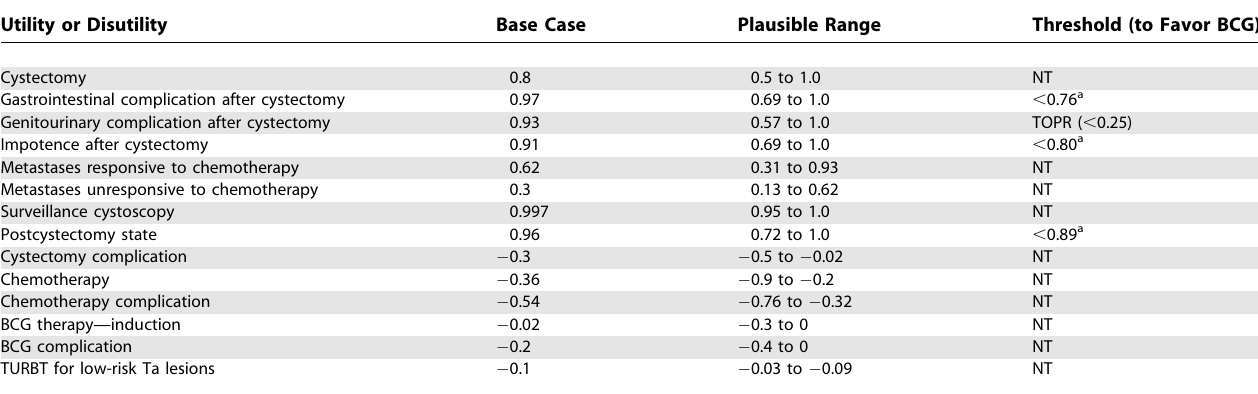
Table 2. One-Way Sensitivity Analysis Results for a 60-Year-Old Potent Male: Utilities and Disutilities Utility or Disutility Base Case Plausible Range